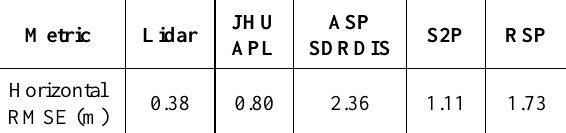
Table 2 Relative accuracy measured for lidar and MVS